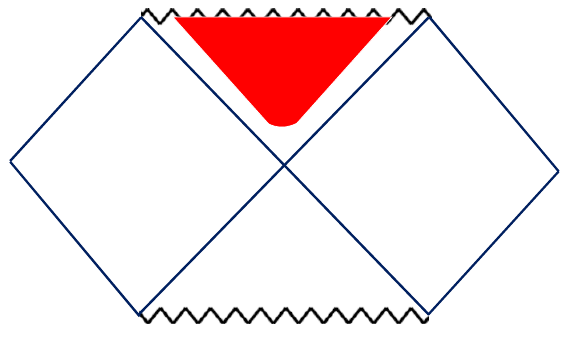
Figure 4 . A typical folded string inside the SL(2 ; R ) k = U(1)